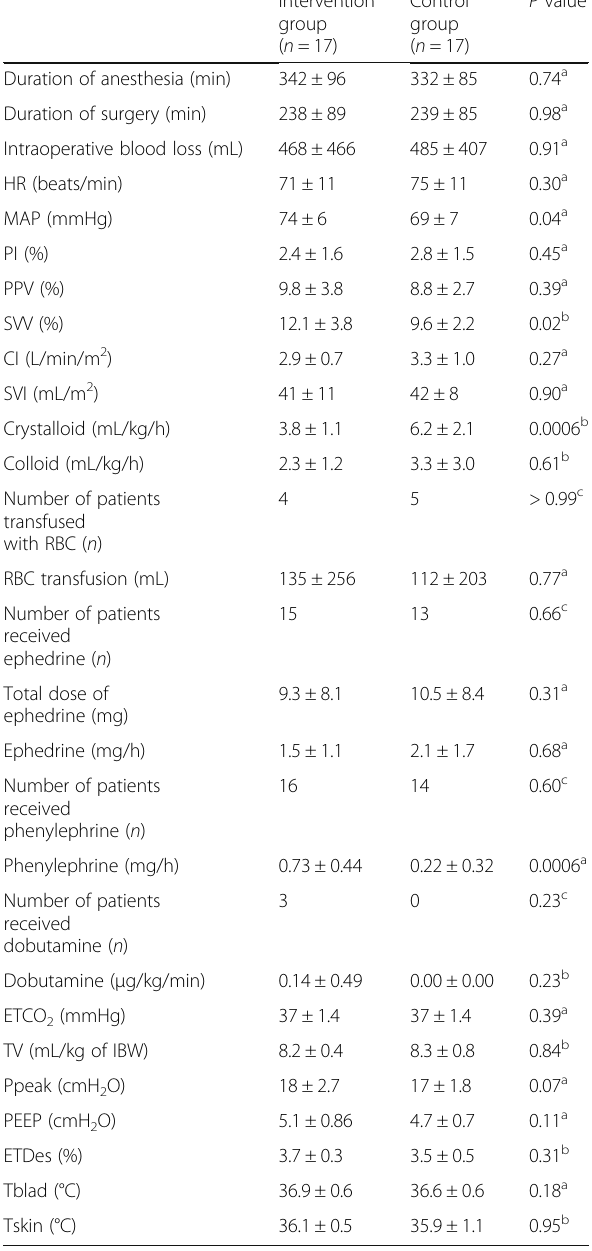
Table 3 Intraoperative